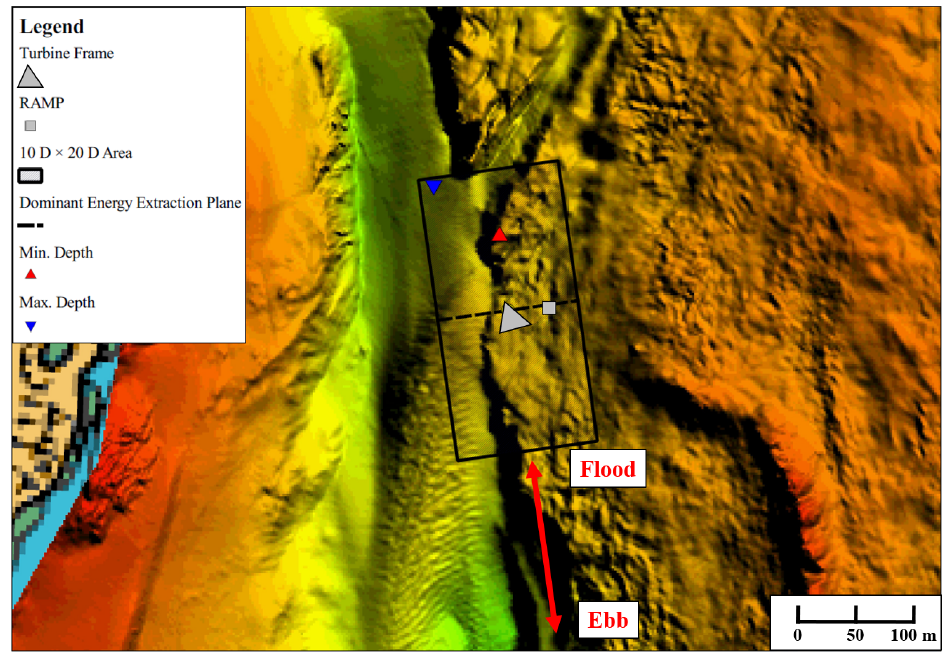
Figure 6. Bathymetry within the vicinity of the turbine and the 10 D × 20 D area of interest.